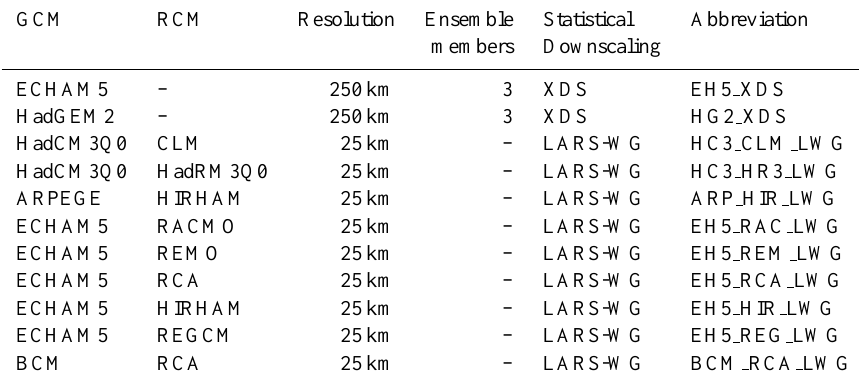
Table 2. Selected GCMs and RCMs. GCM RCM Resolution Ensemble Statistical Abbreviation members Downscaling ECHAM5 – 250km 3 XDS EH5